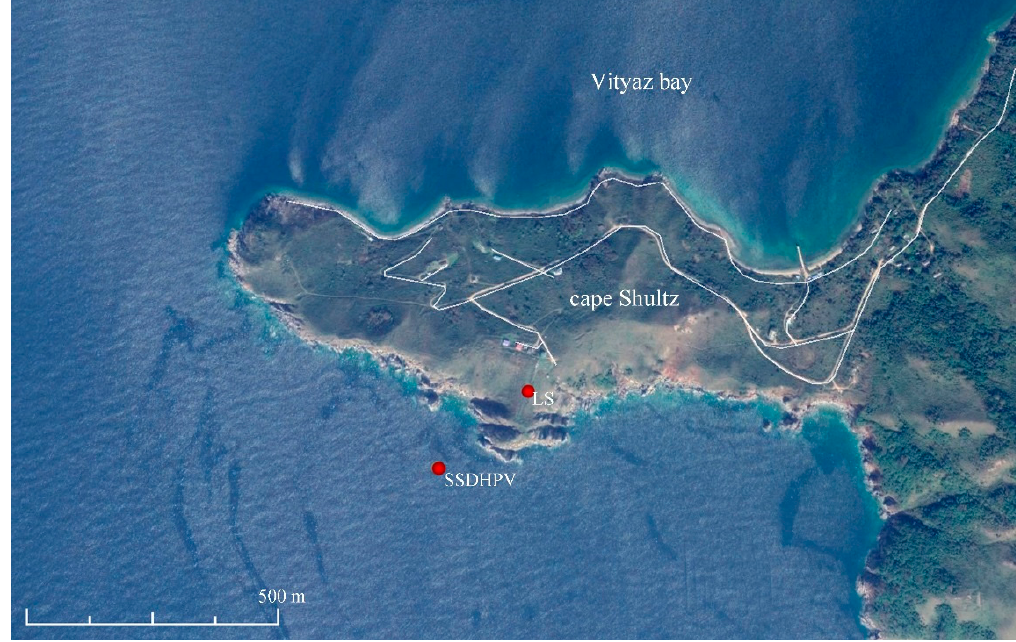
Figure 6. Schematic map of location of the supersensitive detector of hydrosphere pressure variations (SSDHPV) and the 52.5 m laser strainmeter (LS).